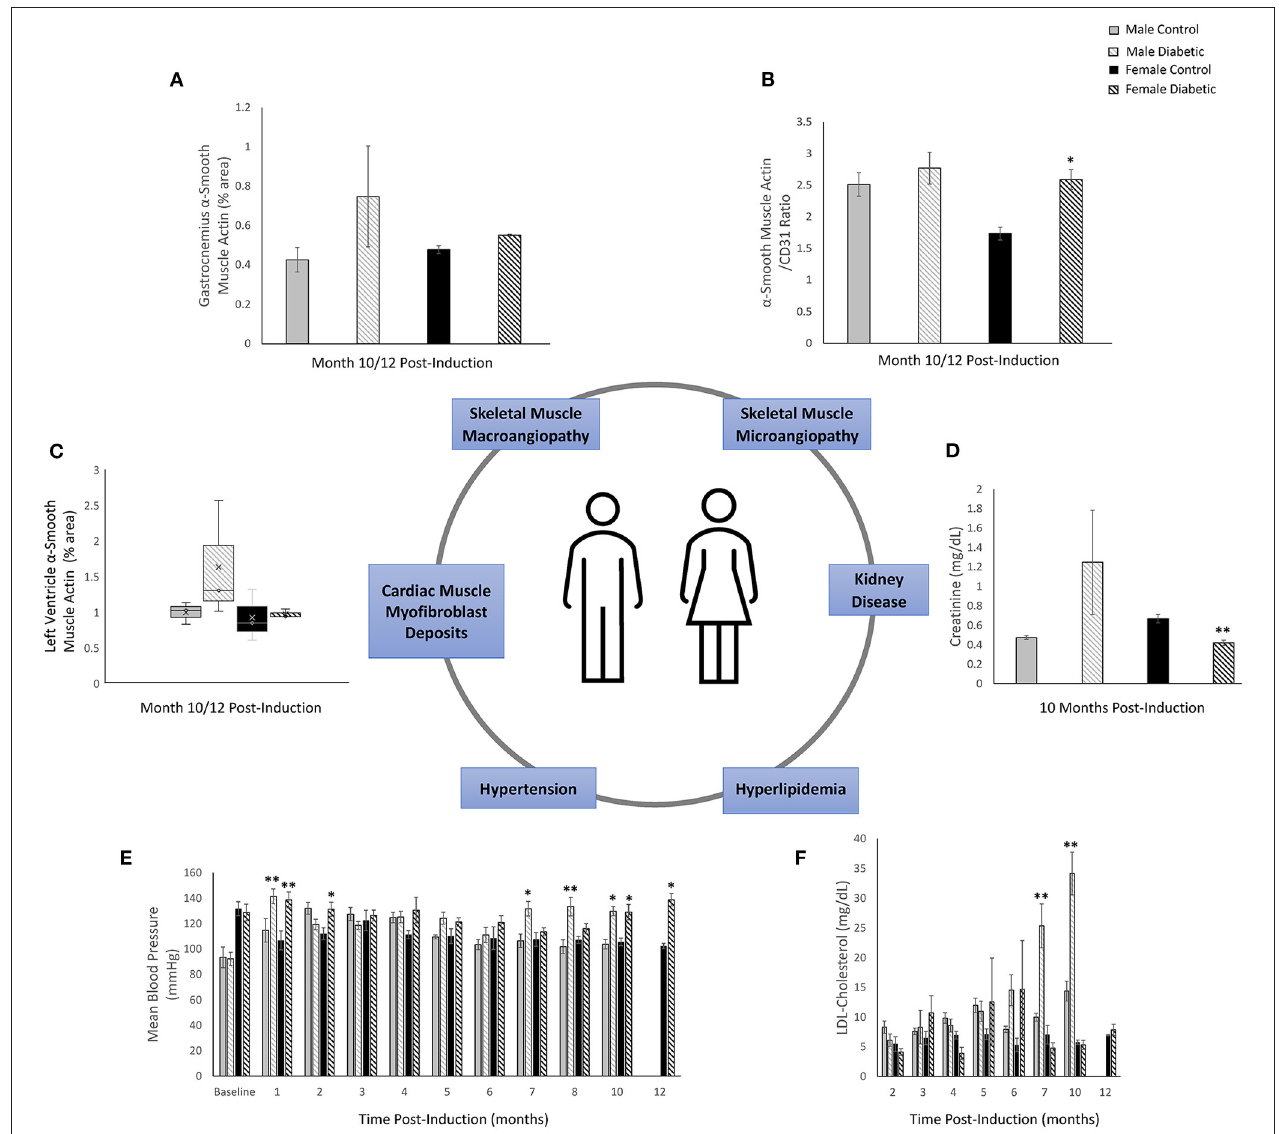
FIGURE 9 | Sex-related differences in key biomarkers in diabetic cardiomyopathy. (A) Leg skeletal muscle (gastrocnemius) large arteriole wall thickness quantified as percentage of α SMA surface area coverage at Month 10 ( n = 3 control male and n = 3 diabetic male) and Month 12 ( n = 3 control female and n = 3 diabetic female) post-induction. (B) Leg skeletal muscle small arteriole smooth muscle wall thickening, quantified as a ratio of surface area coverage of α SMA to CD31. Assessment conducted at Month 10 ( n = 3 control male and n = 4 diabetic male) and Month 12 ( n = 3 control female and n = 4 diabetic female) post-induction. (C) LV myofibroblast deposits quantified as percentage of α SMA surface area coverage on cardiac muscle sections at Month 10 ( n = 3 control male and n = 3 diabetic male) and Month 12 ( n = 3 control female and n = 3 diabetic female) post-induction. (D) Kidney disease evaluated through blood plasma creatinine excretion levels at Month 10 ( n = 4 control male, n = 5 diabetic male, n = 4 control female, and n = 5 diabetic female) post-induction. (E) Hypertension measured though non-invasive tail cuff to determine mean blood pressure in all rats. (F) Hyperlipidemia quantified from low-density lipoprotein (LDL) cholesterol over time. Data was obtained at Month 2 ( n = 3 each of control male, diabetic male, control female, and diabetic female), Month 3–7 ( n = 5 each of control male, diabetic male, control female, and diabetic female), Month 10 ( n = 4 control male, n = 6 diabetic male, n = 4 control female, and n = 5 diabetic female), and Month 12 ( n = 3 control female and n = 5 diabetic female) post-induction. Boxplot mean value is represented with the symbol “X.” Significance at individual timepoints between control and diabetic cohorts of the same sex is indicated (* p < 0.05), (** p < 0.01). Data represented as mean ±